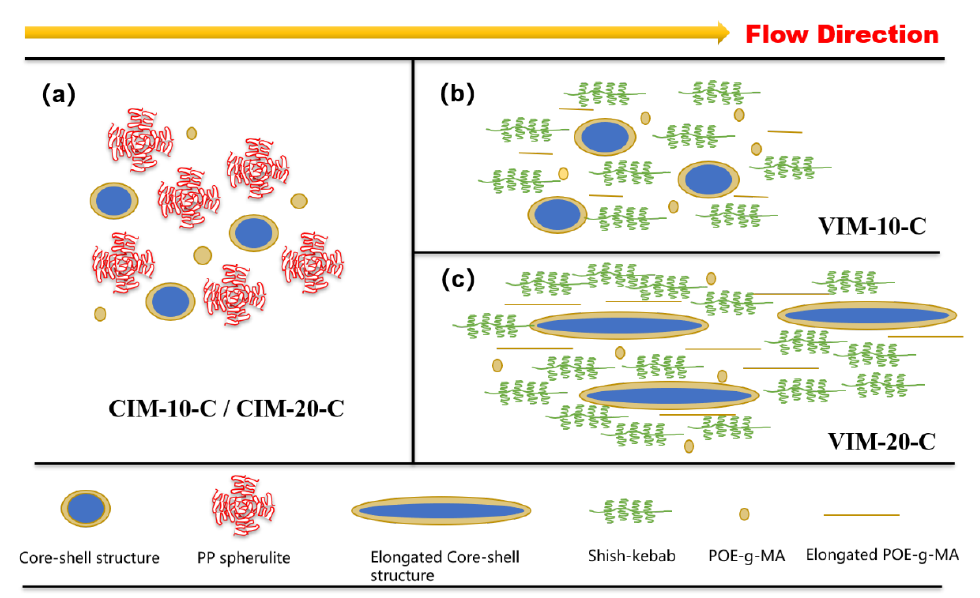
Figure 9. ( a – c ) Schematic drawing of phase morphology and crystalline structure for different samples. Note that the size of all symbols is not to scale.